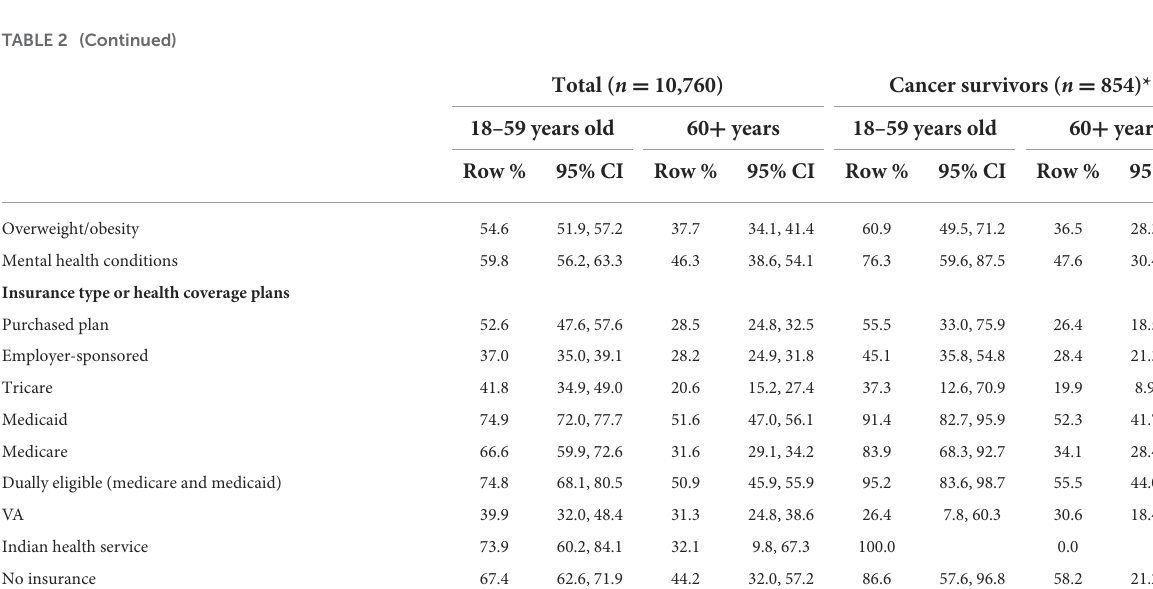
* 2.46%ofparticipantseitherchose:notsure,skippedorrefused,whenaskedabouttheirchronicconditionsincludingcancer. † Response Options: I was laid-off temporarily or furloughed, I was not at my usual jobs because I was caring for children not in school, I was not at my usual jobs because I was caring for an elderly person, I was not at my usual jobs because I was caring for someone with COVID-19, I was not at my usual jobs because I was recovering from COVID-19 or isolating due toexposuretoCOVID-19,IwasunemployedbutlookingforworksinceMarch1st,2020whenCOVID-19beganspreadingintheUS,Iwasunemployedandbeganlookingforworkafter March1,2020whenCOVID-19beganspreadingintheUS. ‡ Cardiometabolicconditions:diabetes,highbloodpressure,heartdisease,liverdiseaseorendstageliverdisease. §Respiratoryconditions:Asthma,chroniclungdiseaseorCOPD,bronchitis,oremphysema.